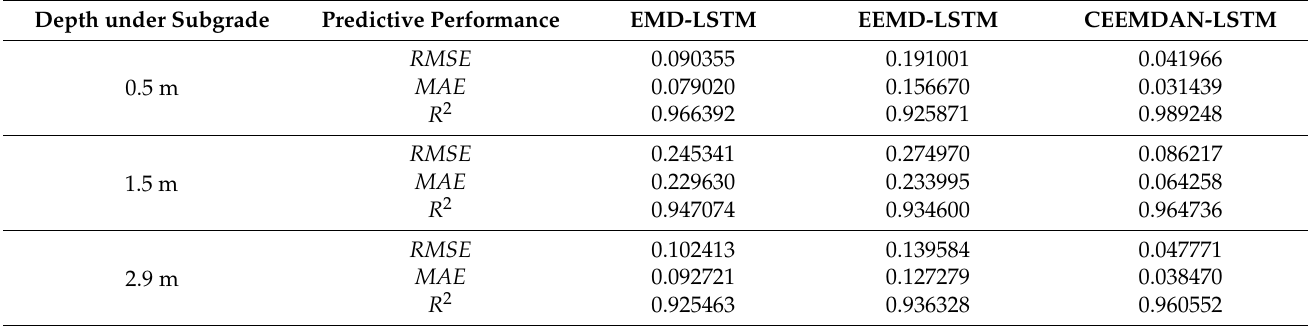
Table 3. Comparison of prediction performance at different subgrade